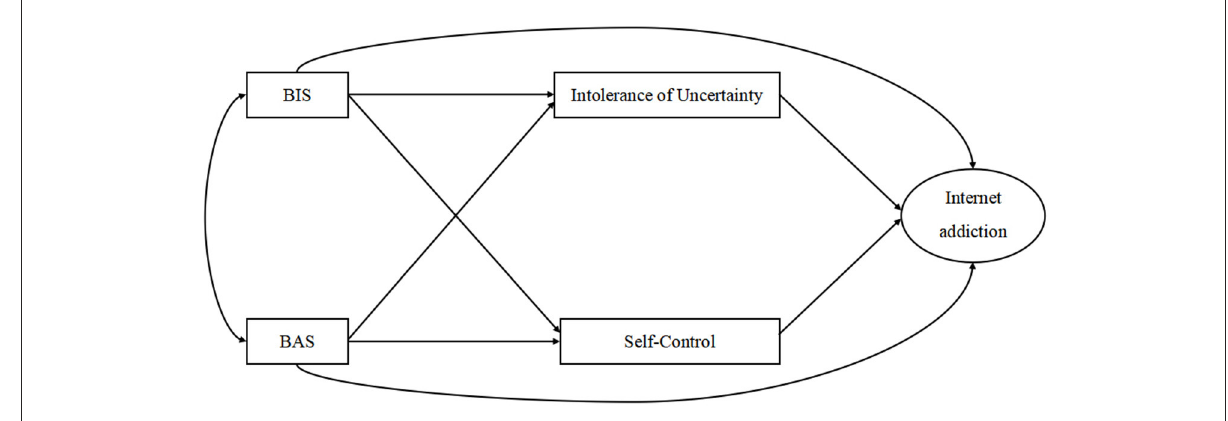
FIGURE1 The supposed